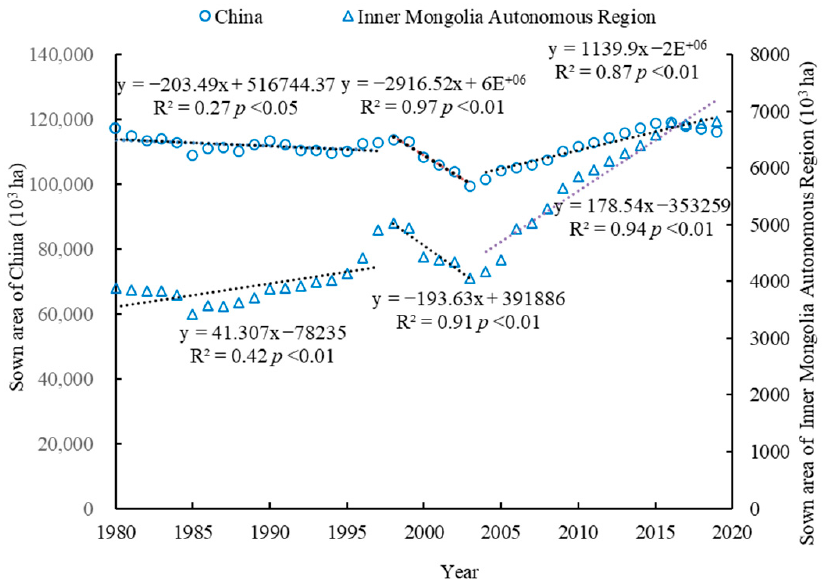
Figure 3. Grain crop sown area of different crops of Inner Mongolia Autonomous Region, in compar- ison with China, for the period of 1980 to 2019.